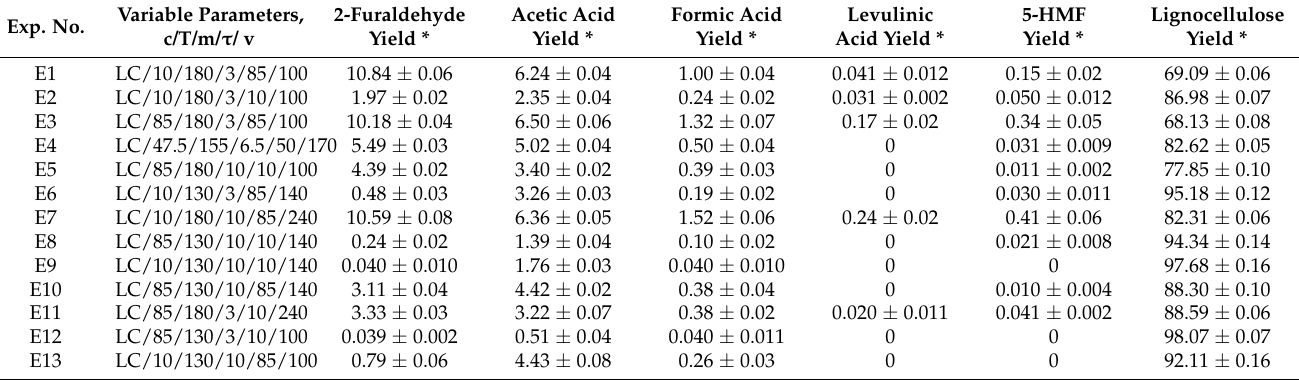
Table 4. Effect of variable pre-treatment process parameters on 2-furaldehyde and acetic acid formation from birch wood chips. Exp.